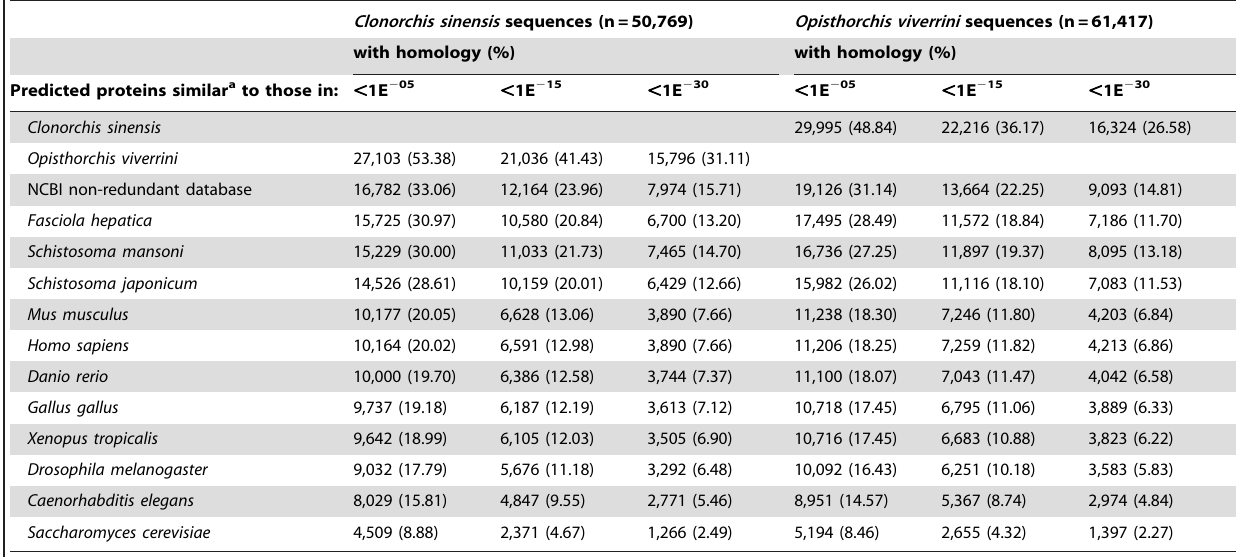
Table 3. Comparative genomic analysis between Clonorchis sinensis , Opisthorchis viverrini , other parasitic trematodes and selected eukaryotic (model)